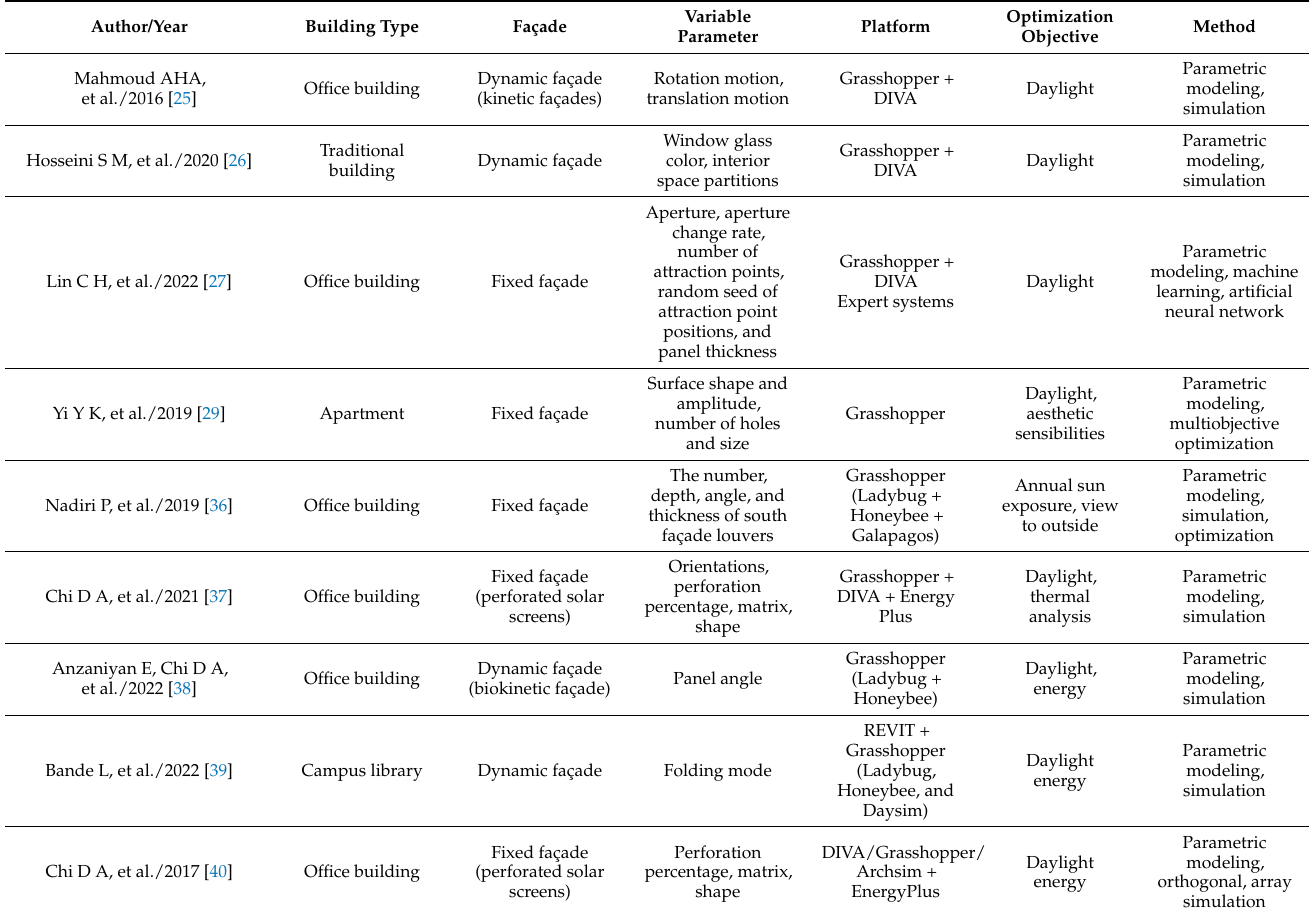
Table 1. Selected representative research papers about building façades